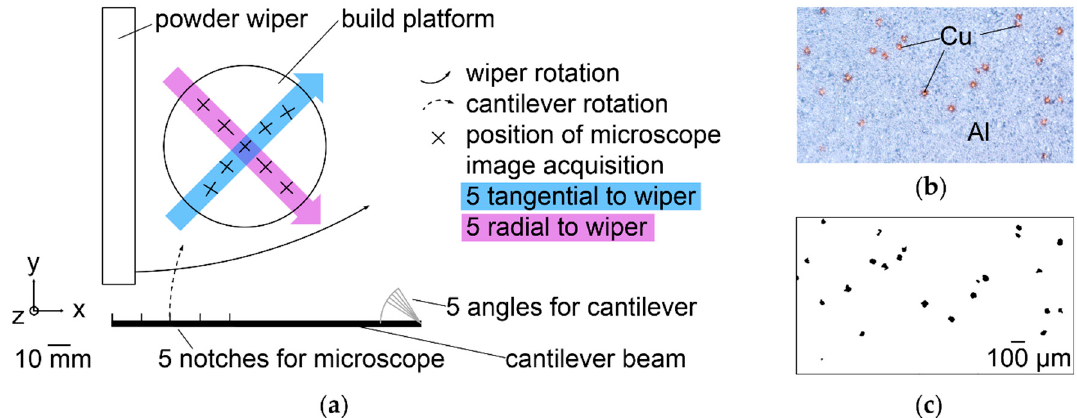
Figure 3. Determination of mixture homogeneity in thin powder layers with a microscope inside the LBM machine; ( a ) setup and imaging positions along and across the direction of powder spreading; ( b ) image with reddish Cu particles contrasting to grey Al ( c ) the same image in black and white. Three binary mixtures with 94.7 wt% Al, 5 wt% Cu, and 0.3 wt% SiO x are analyzed with the